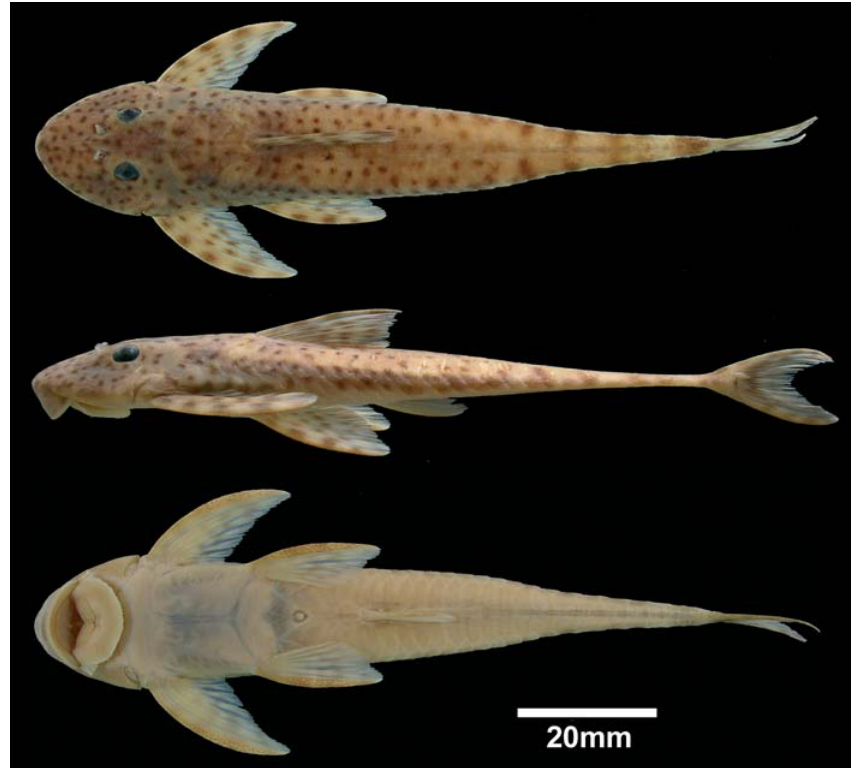
Fig. 1 . Harttia merevari , MBUCV-V-26578, holotype, 99.4 mm of SL. Dorsal, lateral and ventral